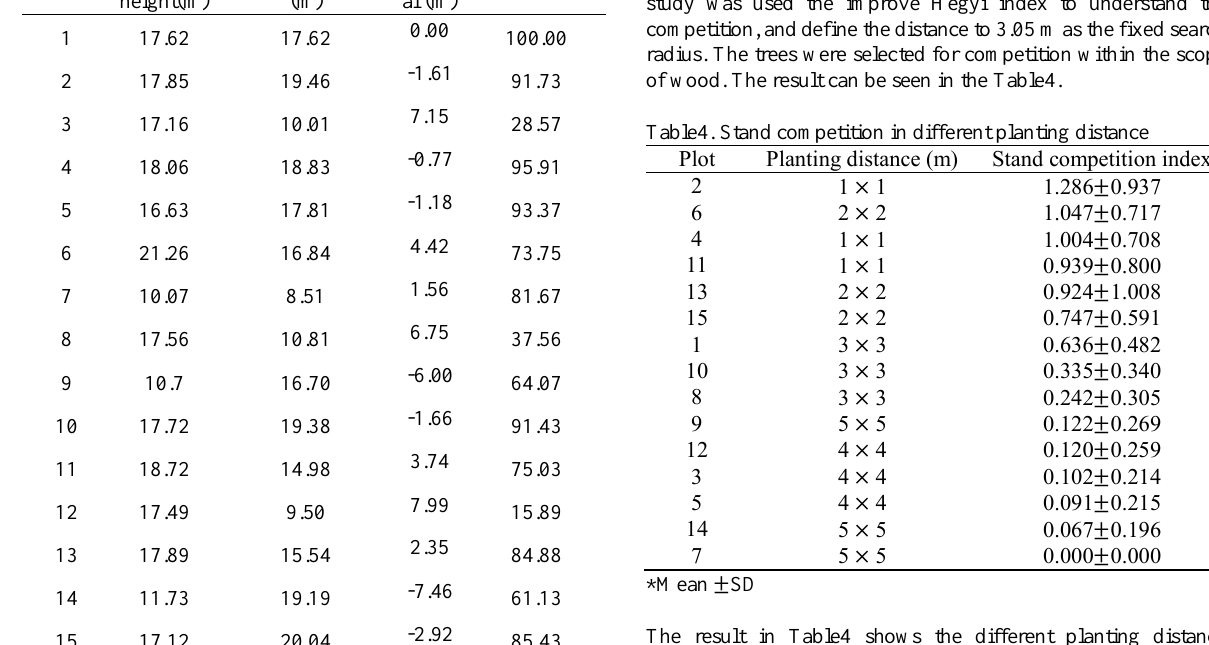
Table3. The result of under branch height estimation Estimate Plot